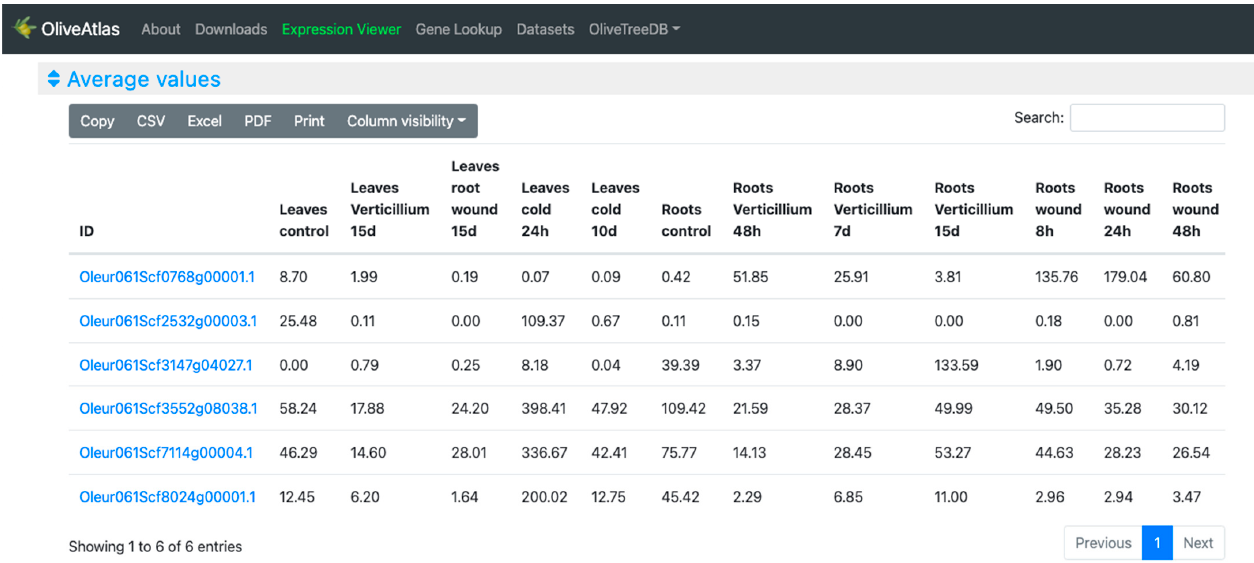
Figure 8. Average values table in the “Expression viewer” tool of OliveAtlas. More experimental data are available when scrolling to the right of the